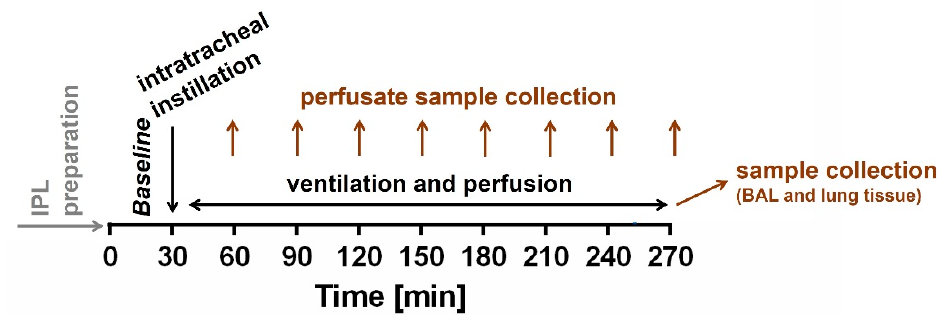
Figure 6. Scheme of experiments: IPLs were prepared from mice and ventilated and perfused for the next 30 min as baseline. Afterwards, the lungs were instilled via tracheal cannula with a 0.9% sodium chloride (control), welding fume particles (WFs) or the soluble fraction of WFs (SF-WFs). The experiments were planned for 270 min total. After 60 min, perfusate sample collection began and was repeated every 30 min. At the end of the experiments, BAL and lung tissue were collected.